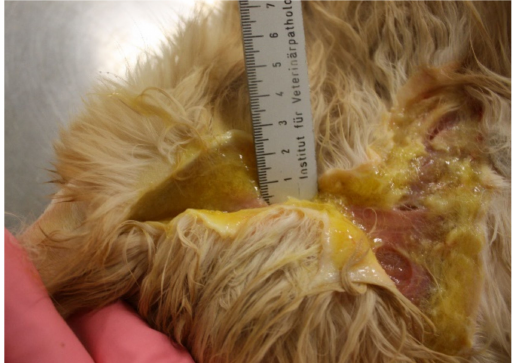
Figure 11. Jaundice and oedema of the subcutaneous tissue at necropsy of a cat with VS-FCV infection (case 11, [102]). ©Institute of Veterinary Pathology, Vetsuisse Faculty